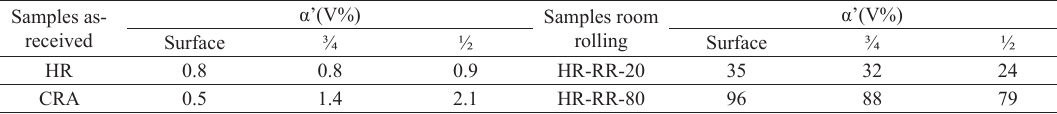
Table 3. Martensite volumes after cryogenic rolling and after effective strain in rolling and tensile test at room temperature. Samples cryogenic